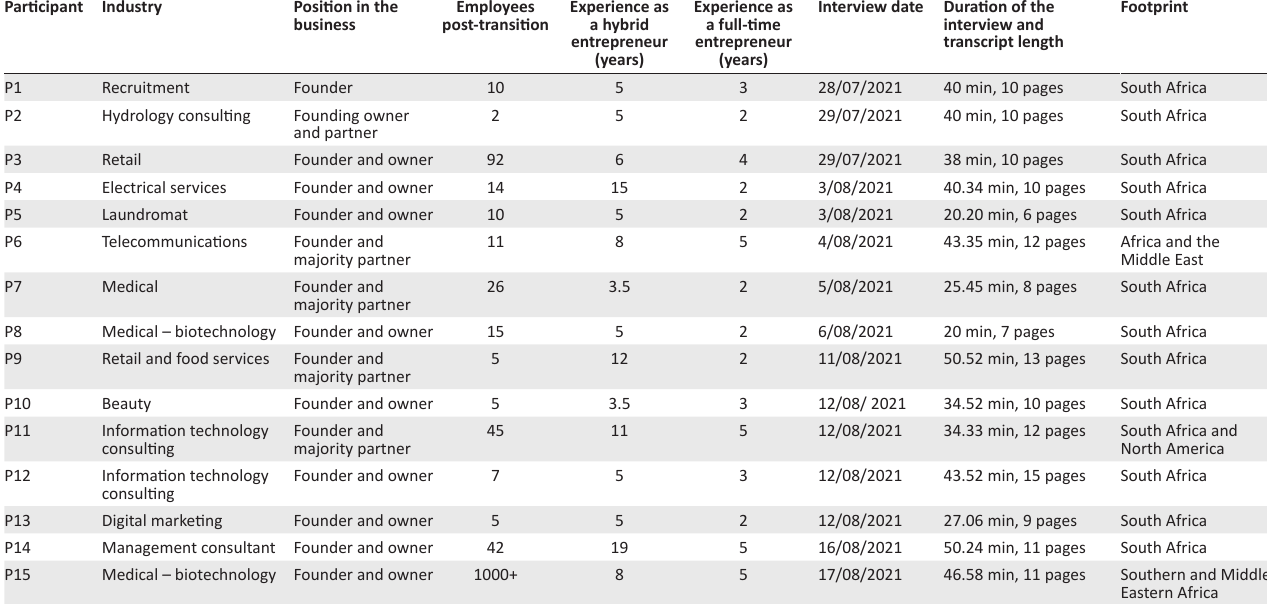
TABLE 1: List of participants. Participant Industry